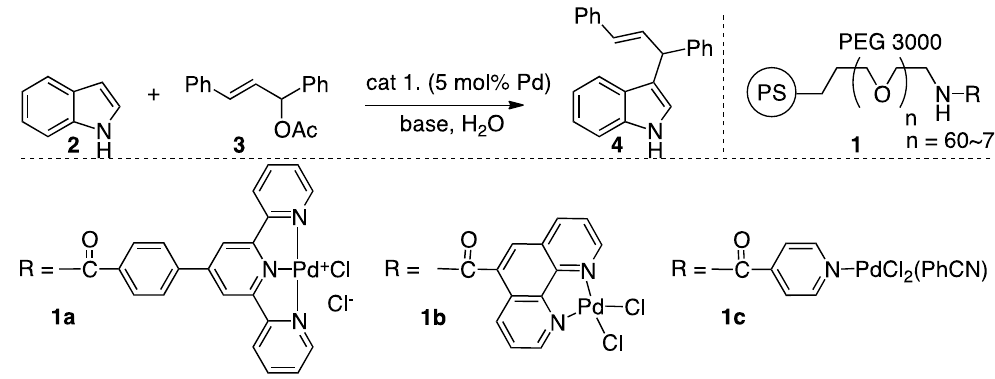
Table 1. Friedel–Crafts-type alkylation of indole in water using catalysts 1 and several bases a .